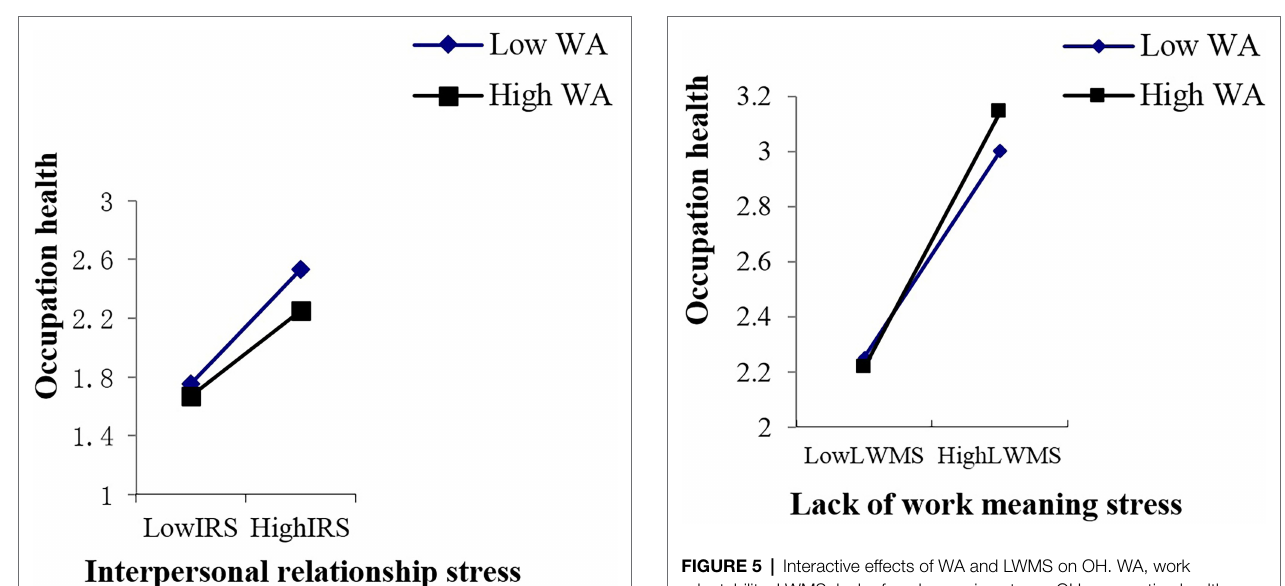
FIGURE 5 | Interactive effects of WA and LWMS on OH. WA, work adaptability; LWMS, lack of work meaning stress; OH, occupation health.